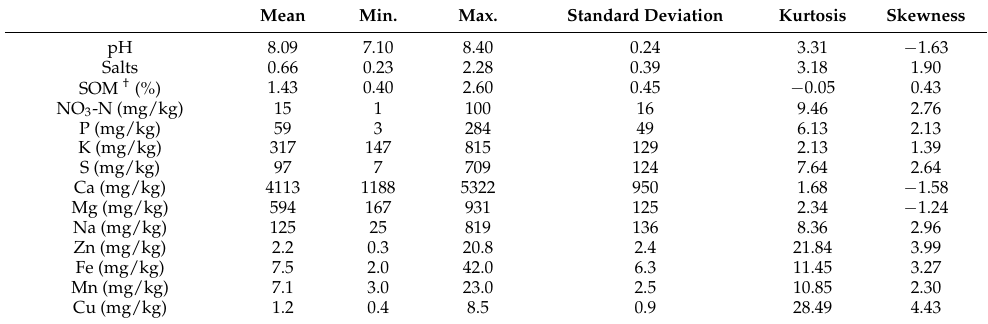
Table 6. Descriptive statistics of soil properties for the entire